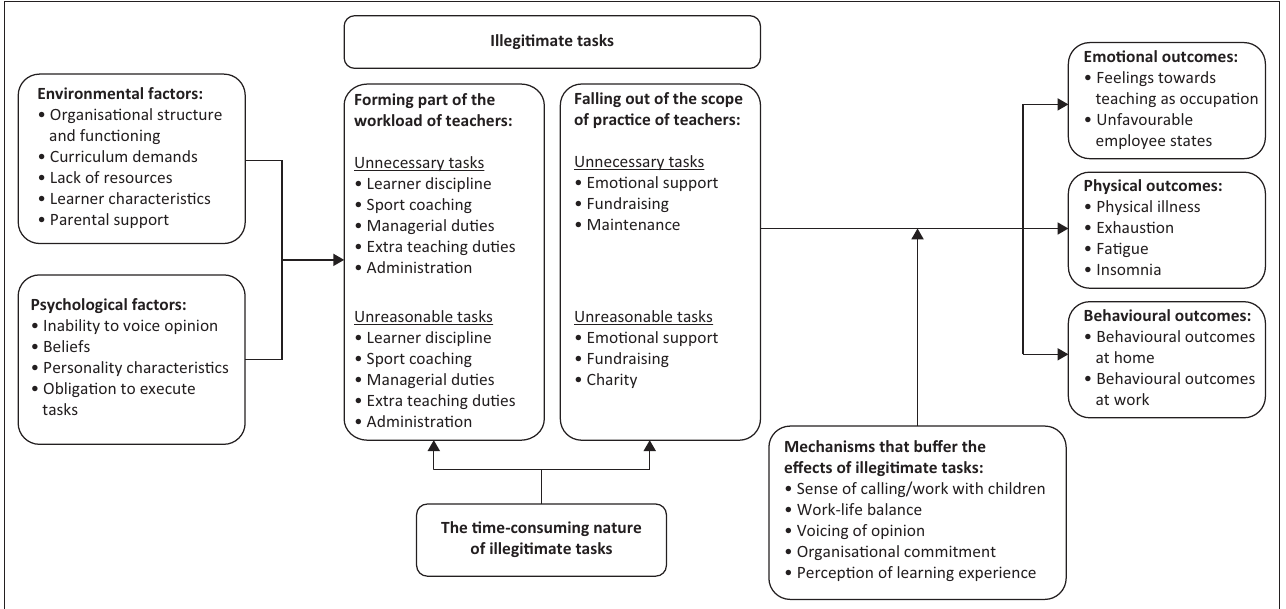
FIGURE 1: A proposed framework of illegitimate tasks derived from the findings of the